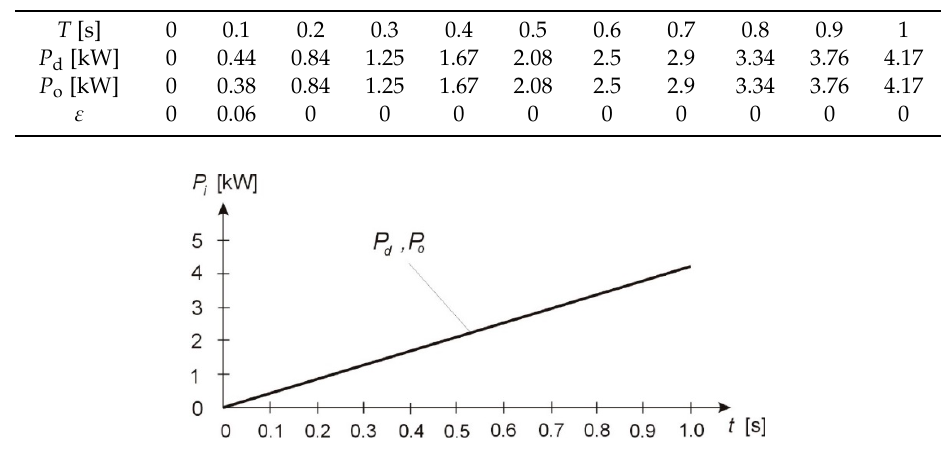
Figure 3. Power curve for the TP.